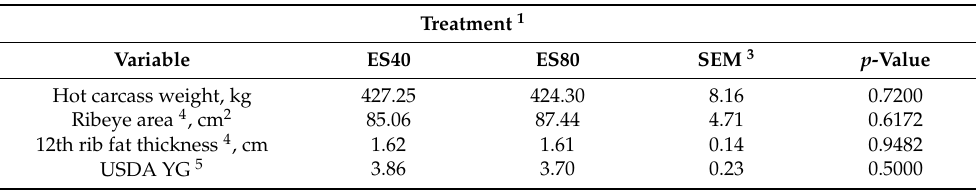
Table 1. Least square means for carcass characteristics of carcasses subjected to 40 or 80 V of electrical stimulation for 60 s in 4 s on, 2 s off intervals prior to chilling.